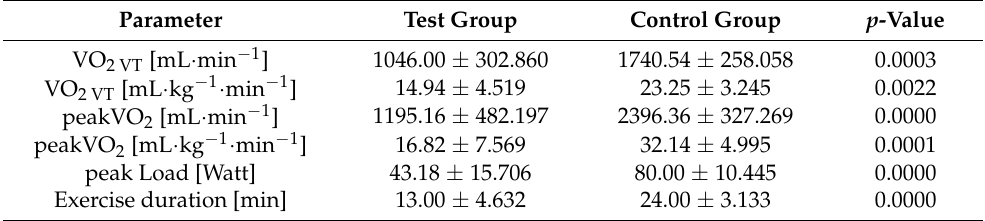
Table 1. Comparison of peak oxygen uptake and oxygen consumption obtained at the ventilatory threshold level.